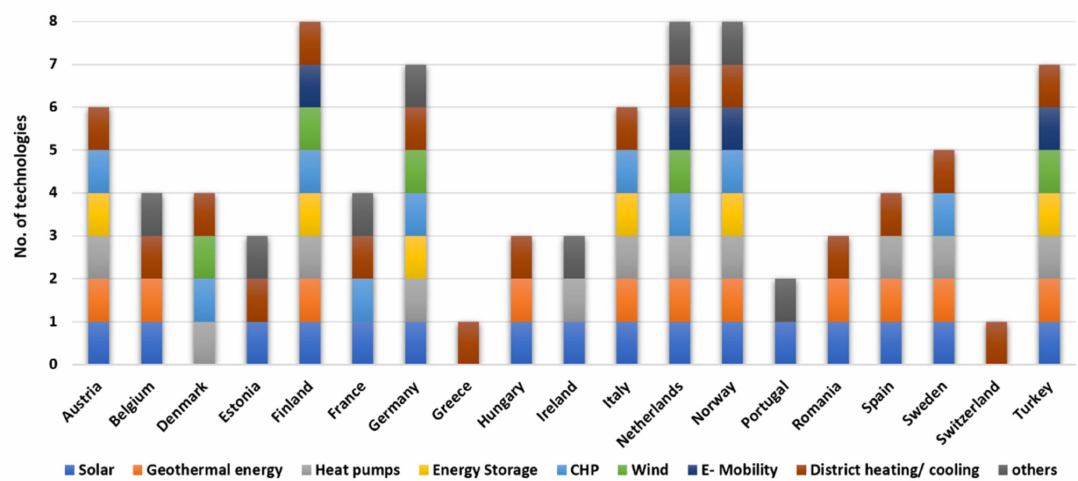
Figure 8. Country-wise approach of energy